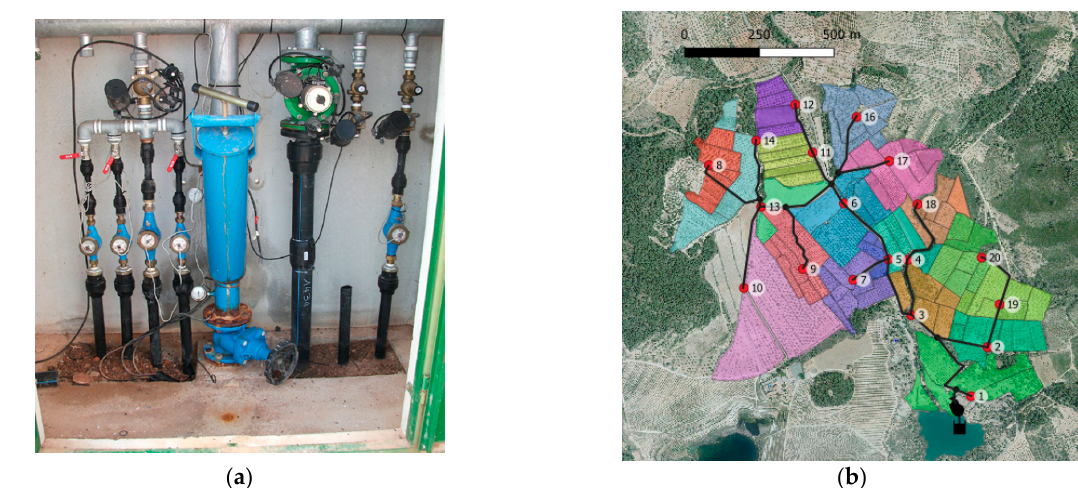
Figure 1. ( a ) Multioutlet hydrant with a gate valve, mesh filter, water meters, and electrovalves to control each plot. ( b ) GIS analysis of multioutlet hydrant distribution on a pressurized network system in Segorbe (Spain). Irrigable area of 72 ha (102 plots), with an average area per plot of 0.7 ha. Colored field plots correspond to each hydrant.